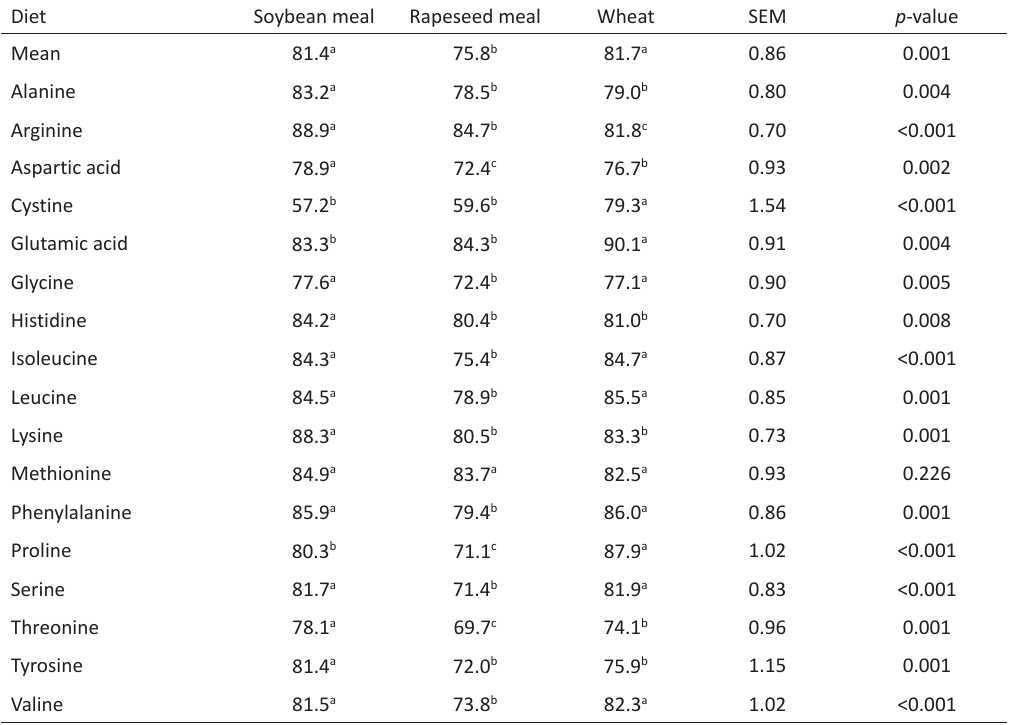
Table 4. Apparent ileal digestibility of amino acids (%) in soybean meal, rapeseed meal and wheat measured with broilers (n=4 per treatment) Diet Soybean